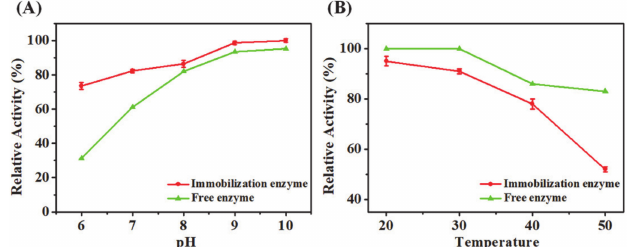
Figure 3. Stability of the immobilized and free His-hCA II ( A ) at di ff erent pHs and ( B )